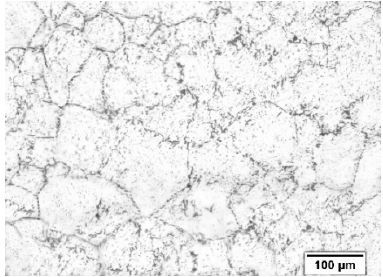
Figure 10. Q345 steel prior austenite structure. Table 6. Detailed parameters of finite element (FE) model.